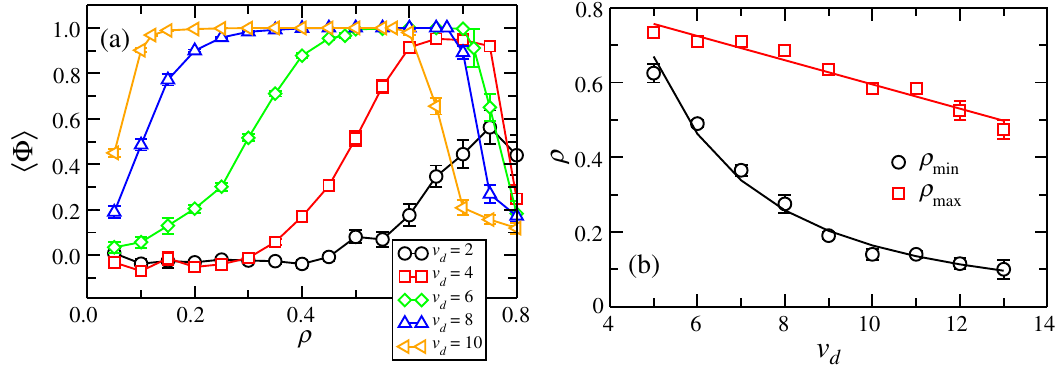
FIG. 3. Dependence of density on drift velocity for ordered states. In panel (a), the average order parameter h Φ i is shown as a function of the density for θ ¼ 0 , b ¼ 8 , H ¼ 2 , and several values of the drift velocity v . In panel (b), we show the maximum (red squares) and d minimum (black circles) densities for which h Φ i ¼ 1 , as functions of the drift velocity. A power-law fit for the minimum density yields ρ ¼ 17 . 6 v − 2 . 03 ¼ 0 . 919 − 0 . 032 v , whereas a linear fit for the maximum density gives ρ . The equations extracted from the fits d min max d ≈ 4 . 67 and v ≈ 28 . 09 . meet at two points, namely, v d d